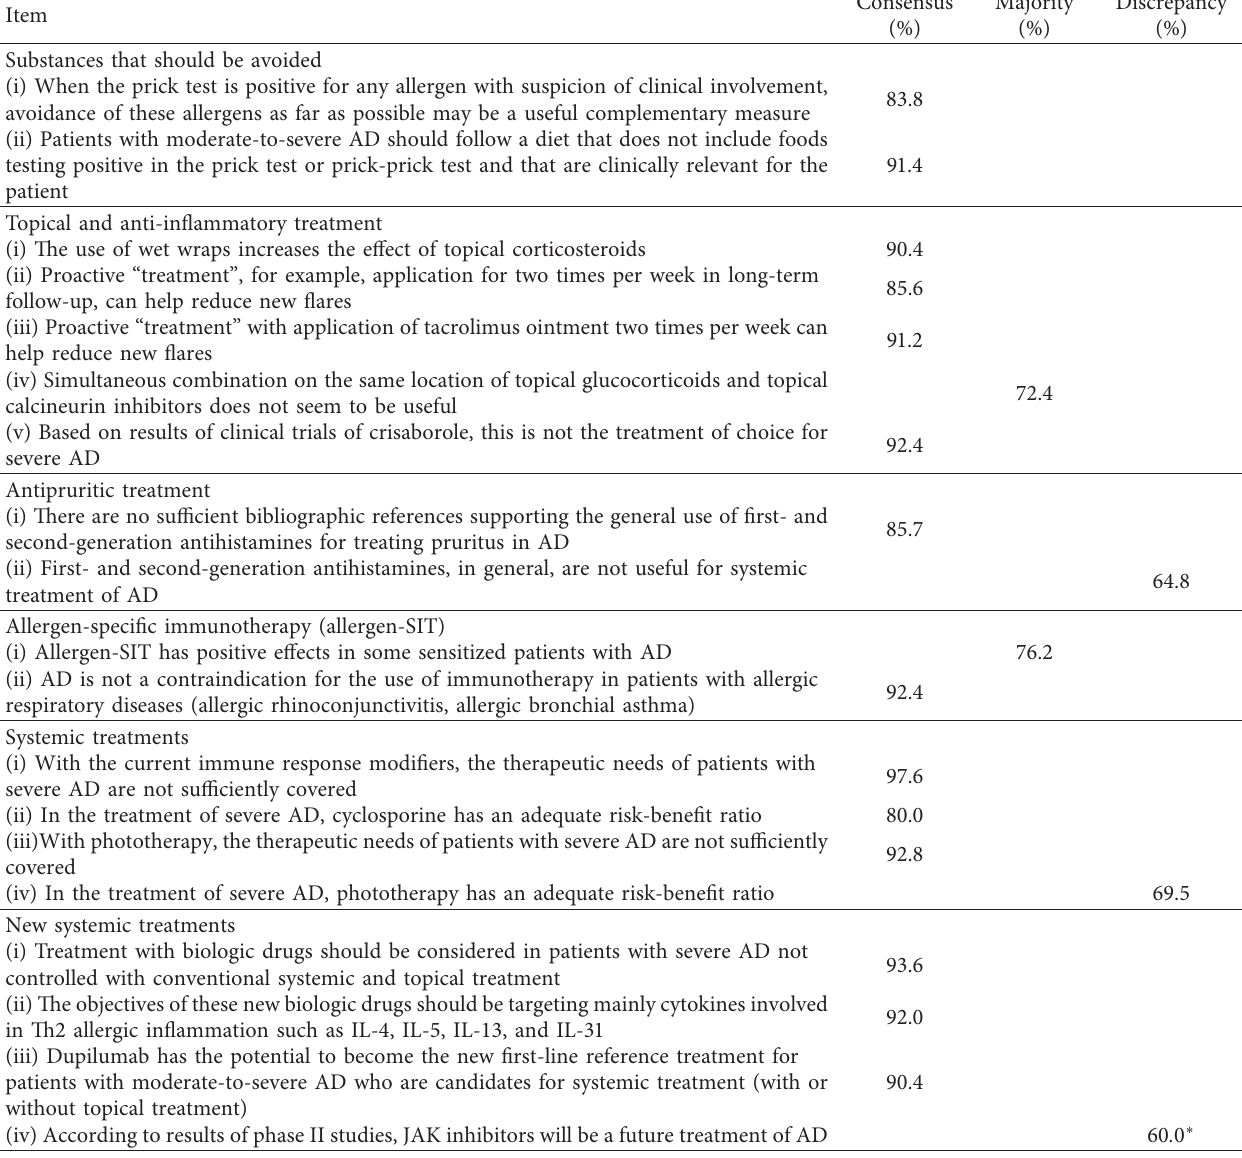
Table 4: Results regarding treatment and follow-up of patients with